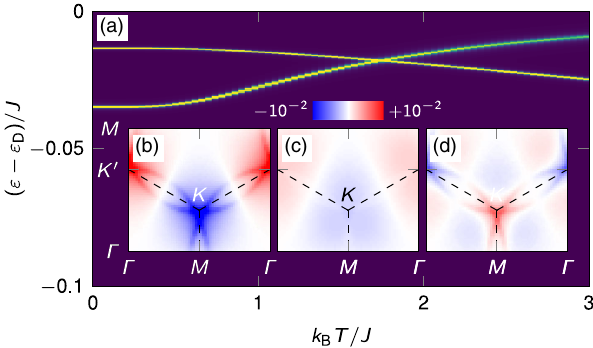
FIG. 13. Temperature dependence of the interaction-induced magnonic Dirac mass at B= ð JS Þ ¼ 1 . 1 for S ¼ 1 and ε Þ as a function D=J ¼ 0 . 15 . (a) Magnonic spectral function A K ð of temperature. Dark blue (bright yellow) color indicates zero ε Þ . (b) – (d) Mass term d 3 (maximal) A in the hexagonal unit cell K ð k T=J ¼ 0 , k T=J ¼ 1 . 8 , and k T=J ¼ 3 , respectively. at k B B B